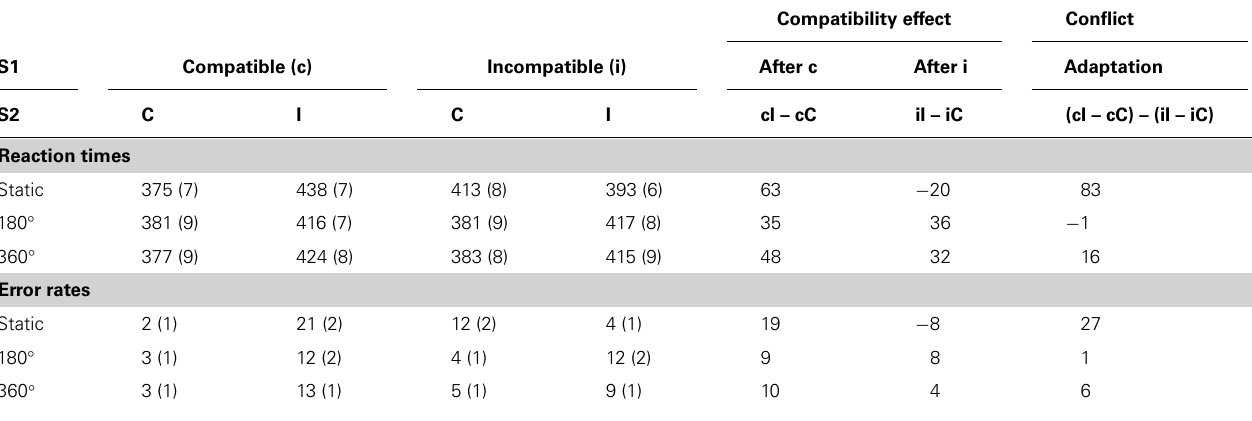
Table 3A | Experiment 3, compatibility and conflict-adaptation results.